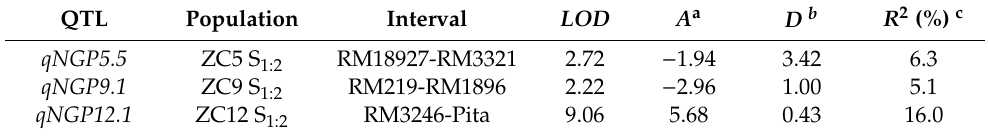
Table 4. QTLs detected for NGP in the ZC5, ZC9, and ZC12